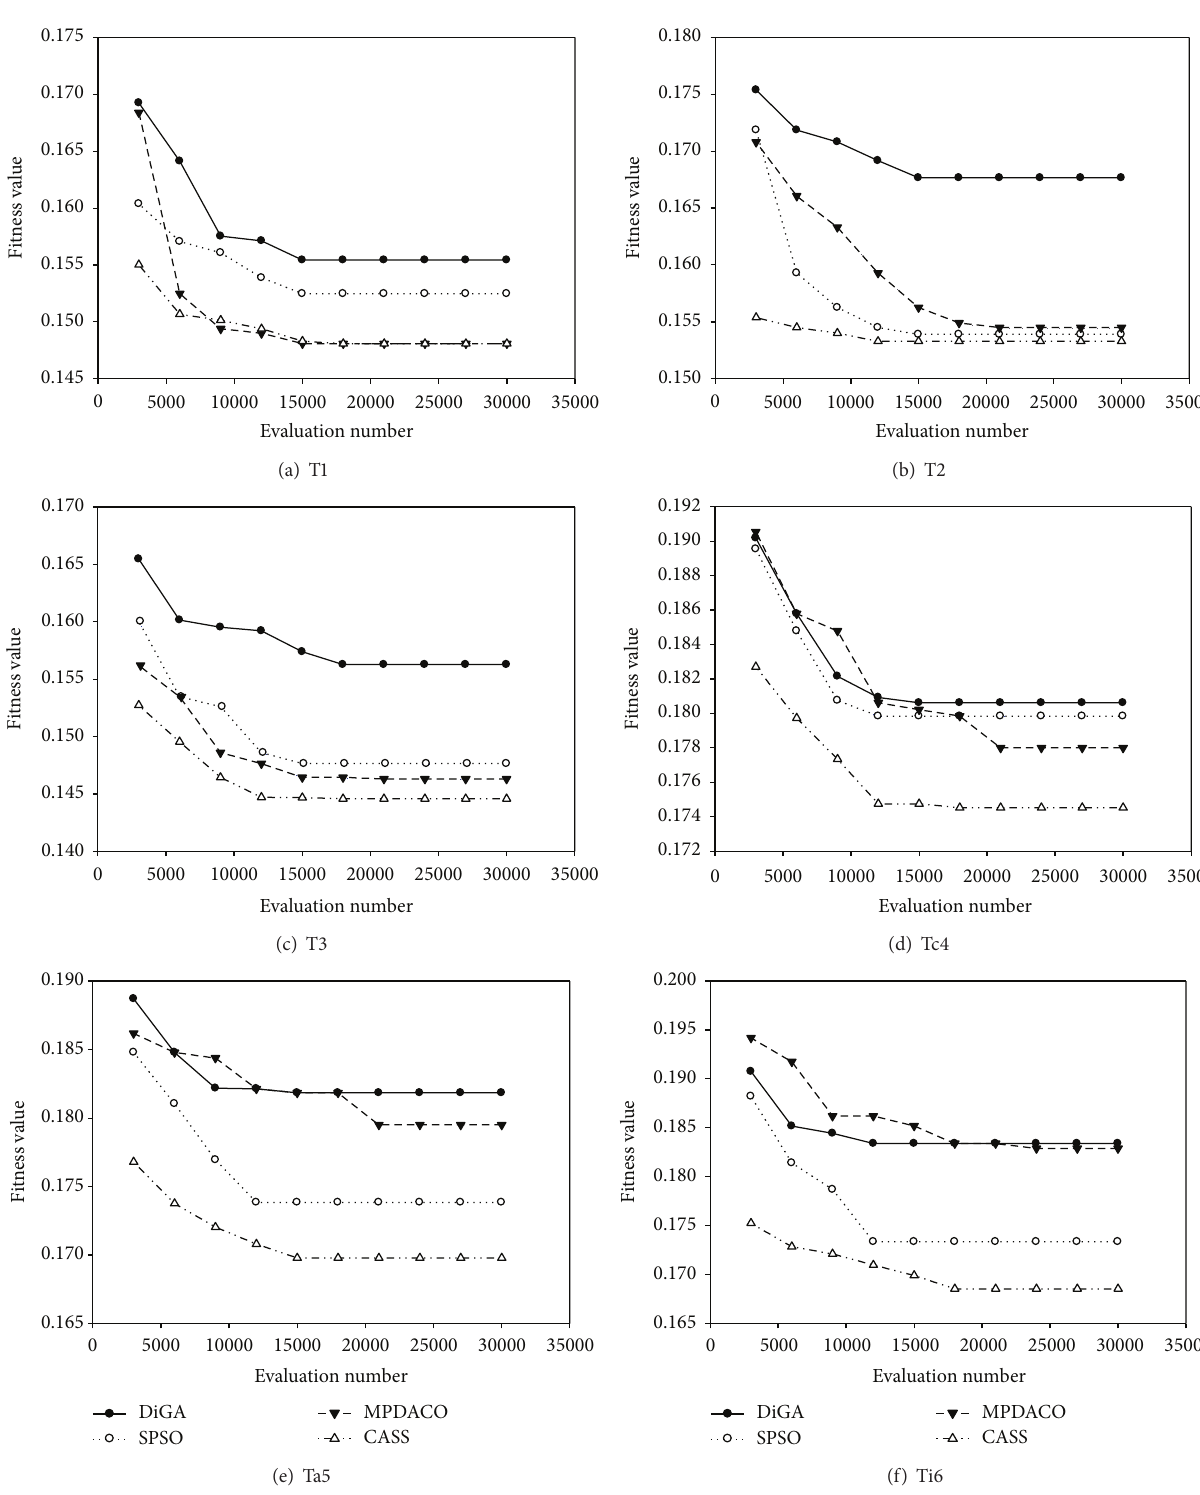
Figure 3: The comparison of the convergent speed on different